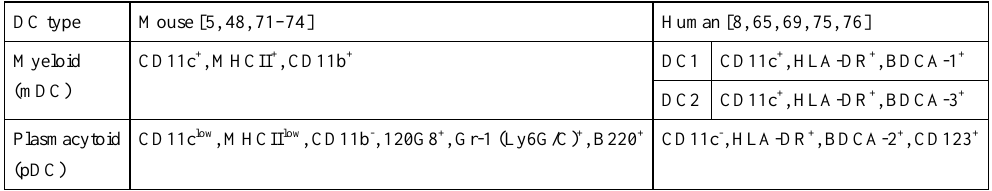
Respiratory tract DC described in the mouse and human lung. DC